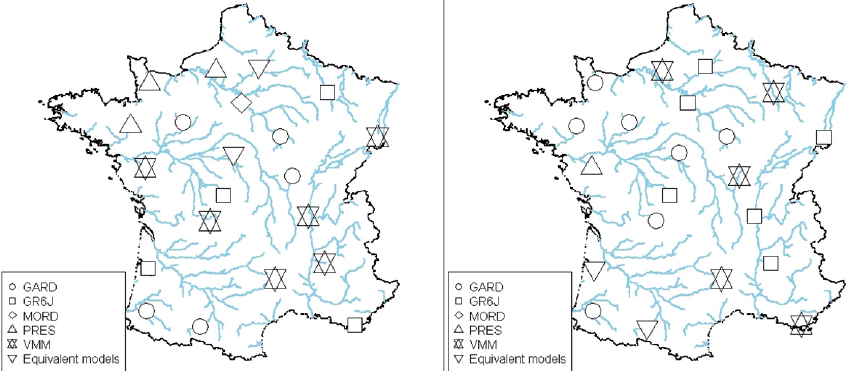
Figure 16. Maps of the model best ranked in forecasting for the mean of all criteria and for validation periods 1 (left panel) and 2 (right panel), for a d + 7 forecasting lead